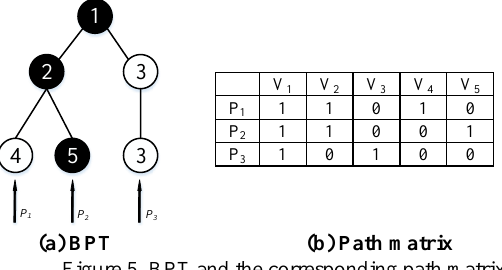
Figure 5. BPT and the corresponding path